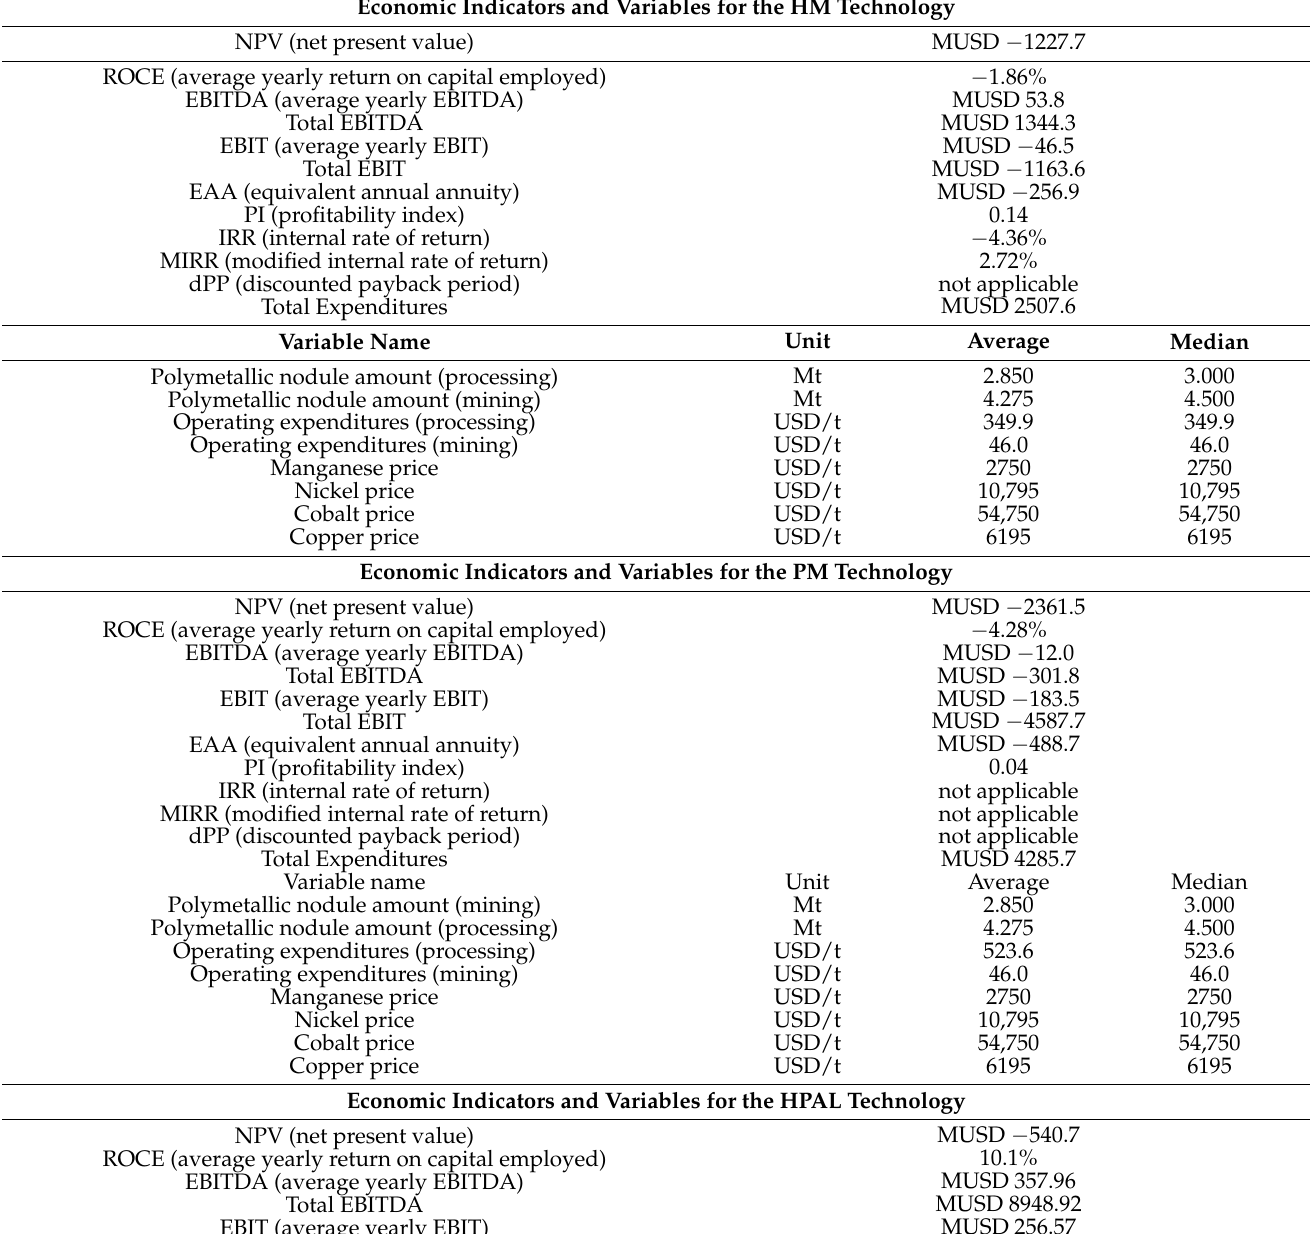
Table 10. Economic indicators and variables for the project, scenario